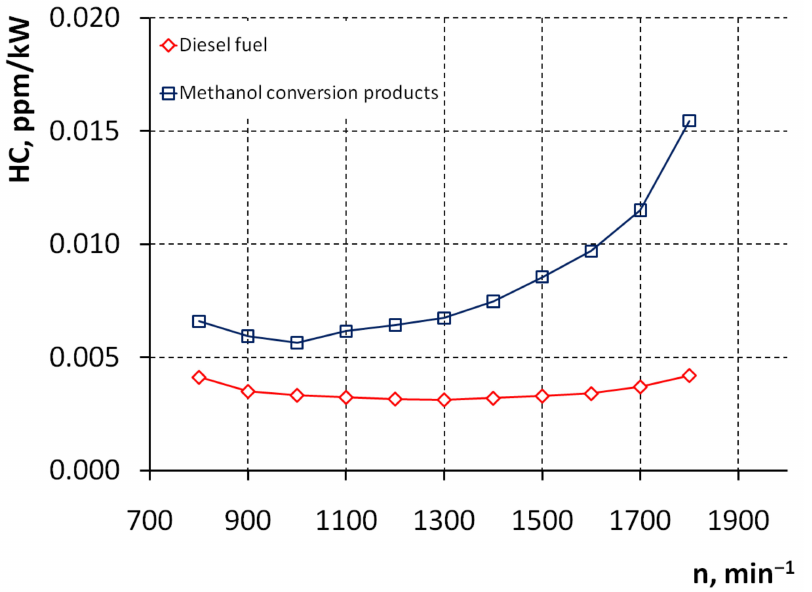
Figure 13. Experimental dependences of the hydrocarbon content in the exhaust gases on the crankshaft speed of the engine n for different motor